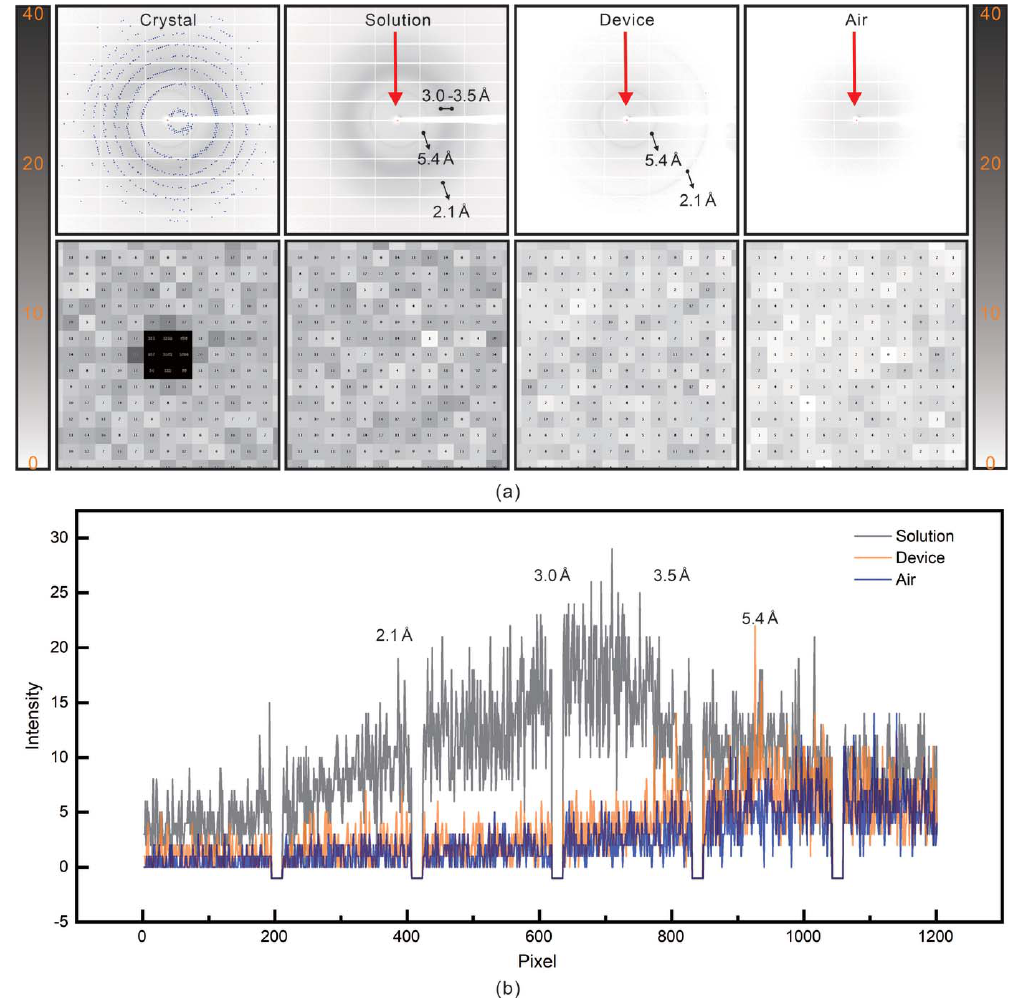
Figure 4 Background scattering analysis. ( a ) Representative diffraction frames and their corresponding magnifications of the crystal, solution, device and air samples. ( b ) Radial profiles of the background scattering intensities of the solution (gray line), device (orange line) and air (blue line) (0 to 1200 pixels along the y -axis of the frame as indicated by the red